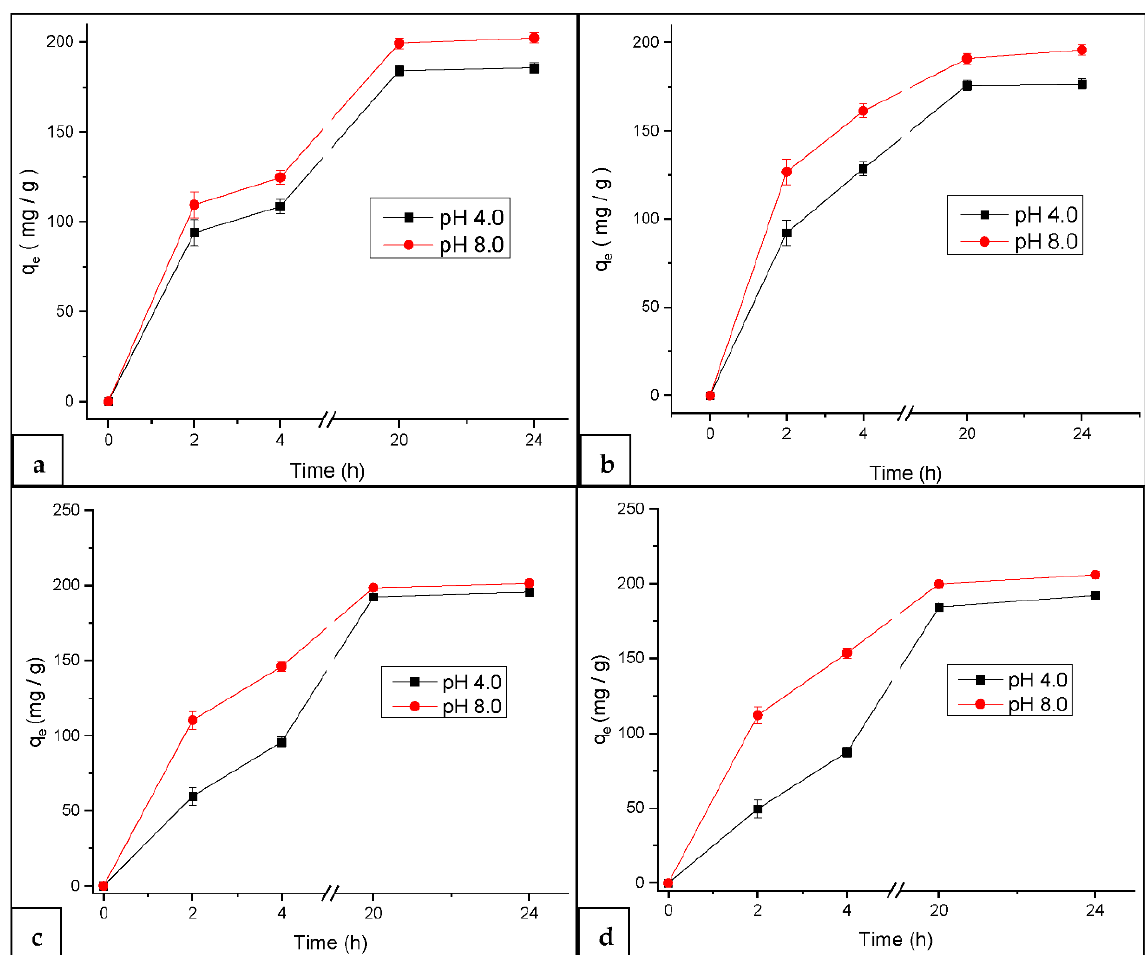
Figure 6. MB adsorption as a function of time at ( a ) 25 °C and ( b ) 50 °C using SAP and at ( c ) 25 °C and ( d ) 50 °C using SAP-AC as adsorbent.